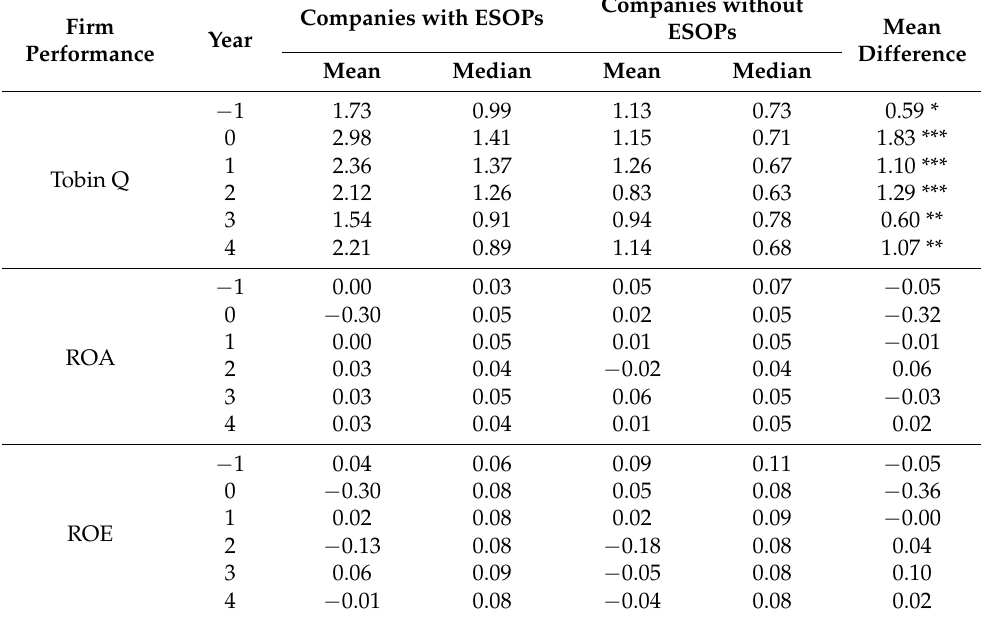
Table 2. Descriptive statistics. This table describes the statistical means and medians of the depen- dent variables of firm performance (ROA, ROE and Tobin’s Q) for the companies with ESOPs and companies without ESOPs. The differences of the means, median, and the t-statistics and p -value between both parties are also reported. Year − 1 refers to a year prior to the first announcement date of ESOPs; Year 0 is a year of the first announcement; and Year 1 to Year 4 represent a range of years from one year to four years after the announcement. *, ** and *** are 90%, 95% and 99% levels of significance,